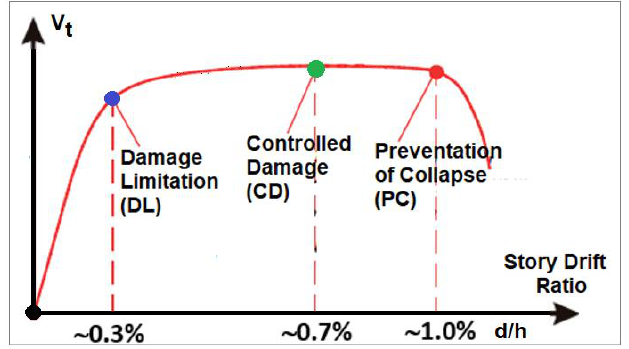
Figure 16. Pushover curve and limit states [104].